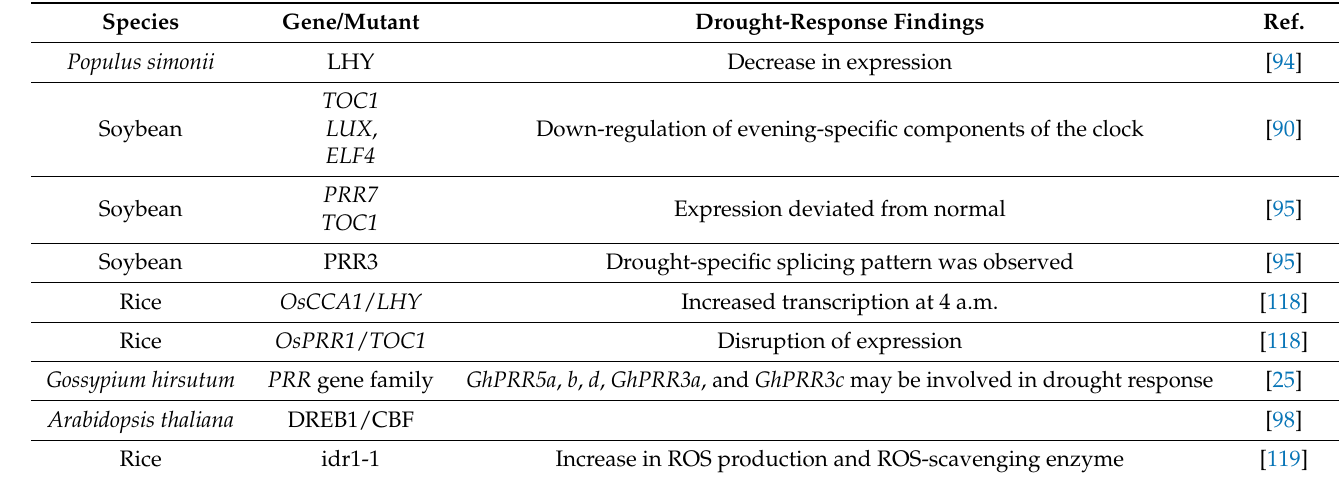
Table 1. Drought-response findings of various plant species regarding circadian clock genes. Gene/Mutant Drought-Response